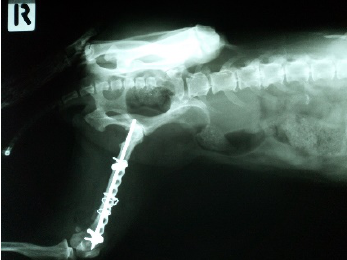
Fig. 7. Ventrodorsally radiography showed finish od operation